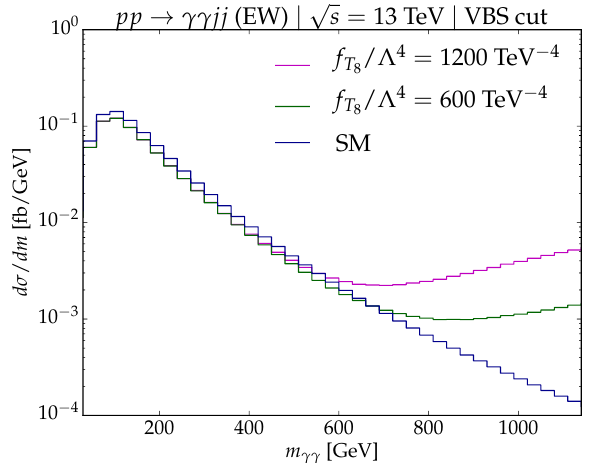
Figure 11 . NLO distributions of the invariant mass of the two photons in the presence of anomalous gauge couplings with the dimension-8 operator de(cid:12)ned in eq.